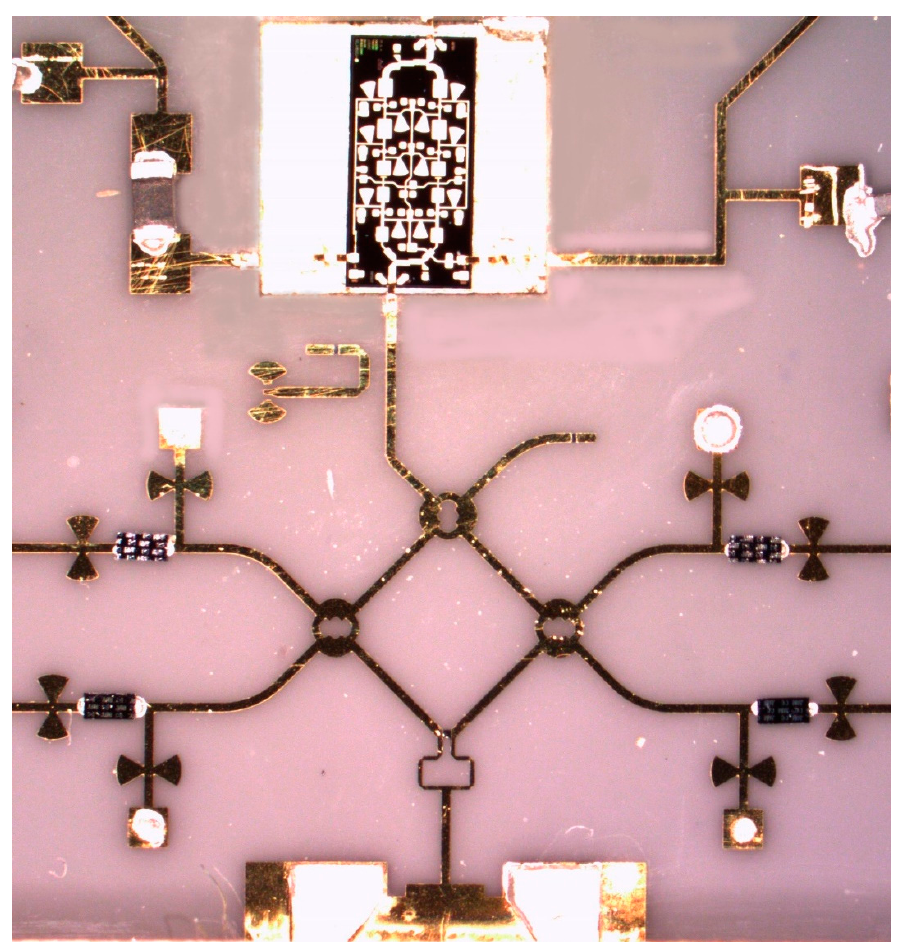
Figure 17. E-band multi-port radar sensor (micro-photograph of bottom part of the MHMIC).